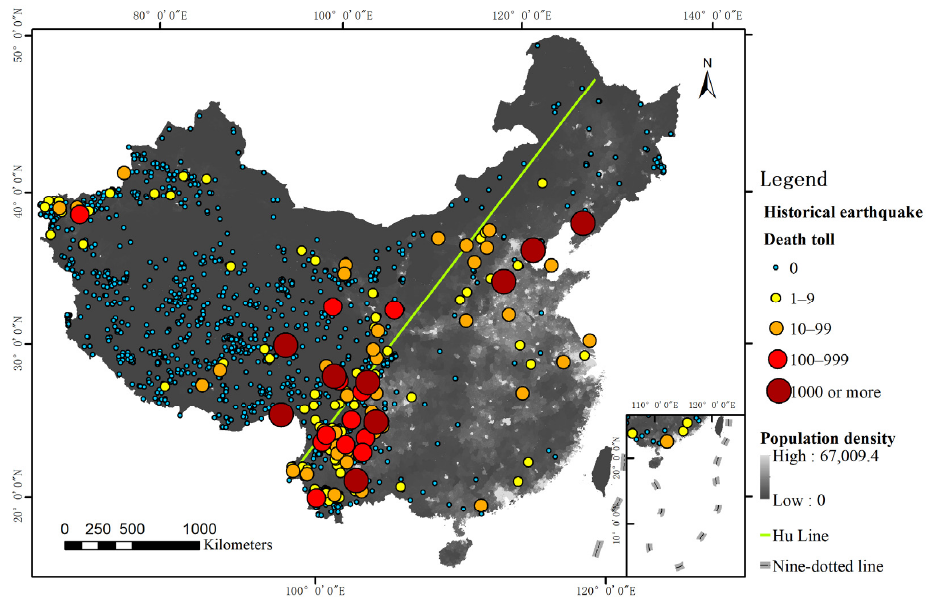
Figure 2. Historical earthquakes and population distribution in China’s mainland.